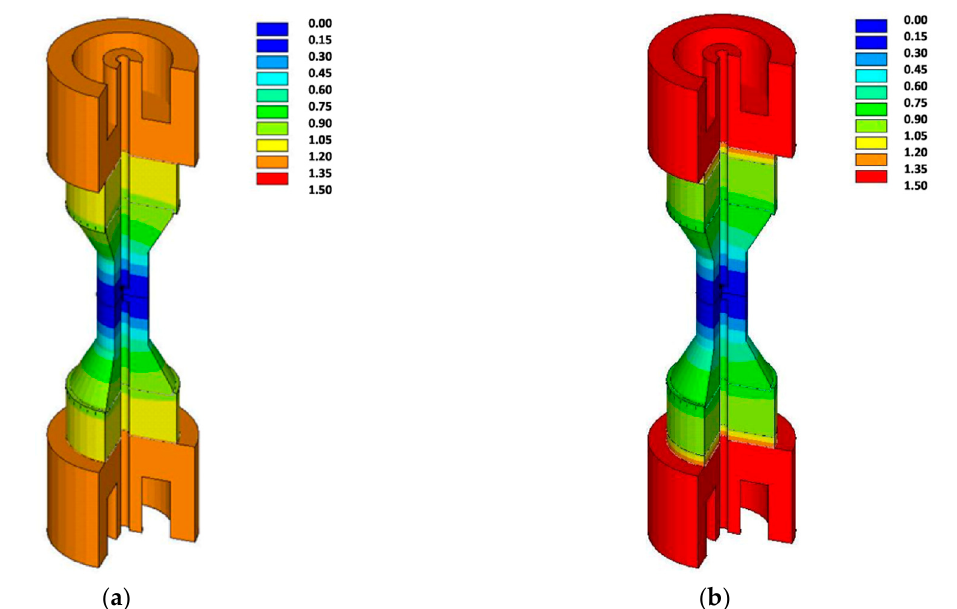
Figure 7. FEM-modeled voltage at 1200 s (holding stage): ( a ) regular setup; ( b ) setup with CFRC spacers.